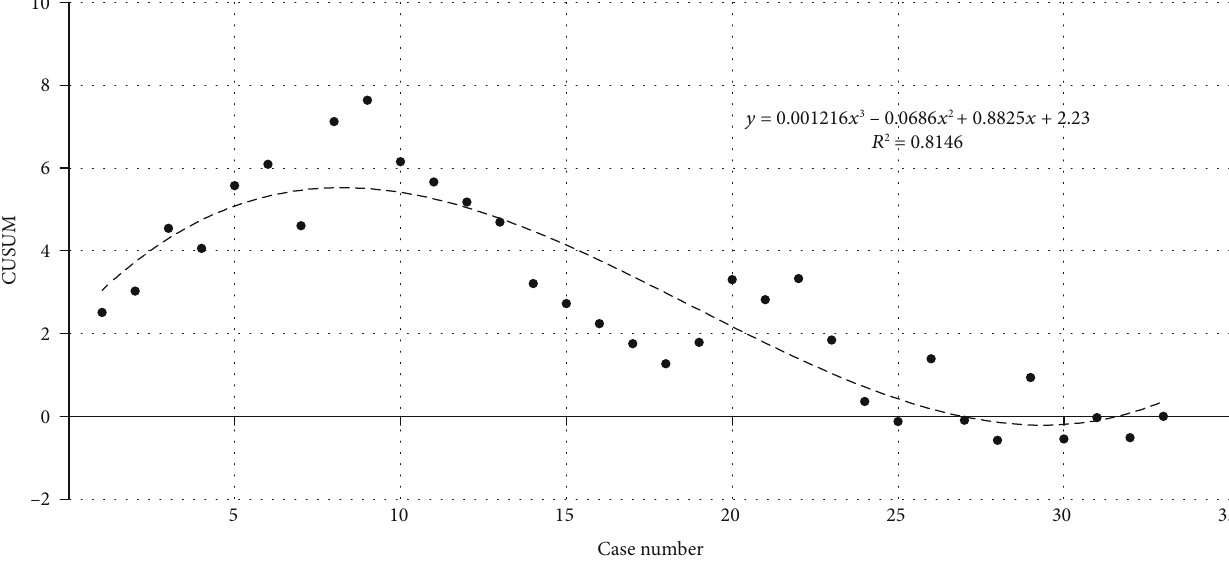
Figure 4: Learning curve for RAG in terms of multidimensional cumulative sum analysis. Dashed line showed the best fi tted curve; the equation was y = 0 : 001216 x 3 – 0 : 0686 x 2 + 0 : 8825 x + 2 : 23 ( R 2 = 0 : 8146 ), where x represented the case number. The cut-o ff value was the 8th